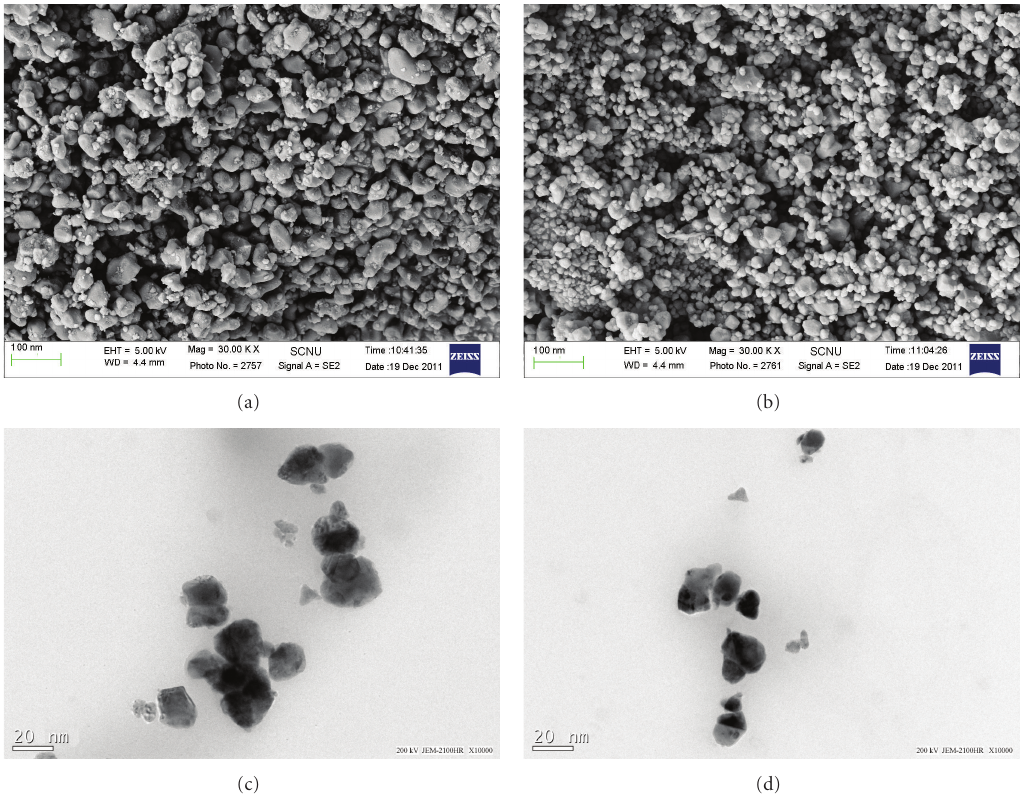
Figure 1: The SEM and TEM images of TiO 2 particles. (a) and (c): pure TiO 2 ; (b) and (d): 2wt% Fe-N-TiO 2 .